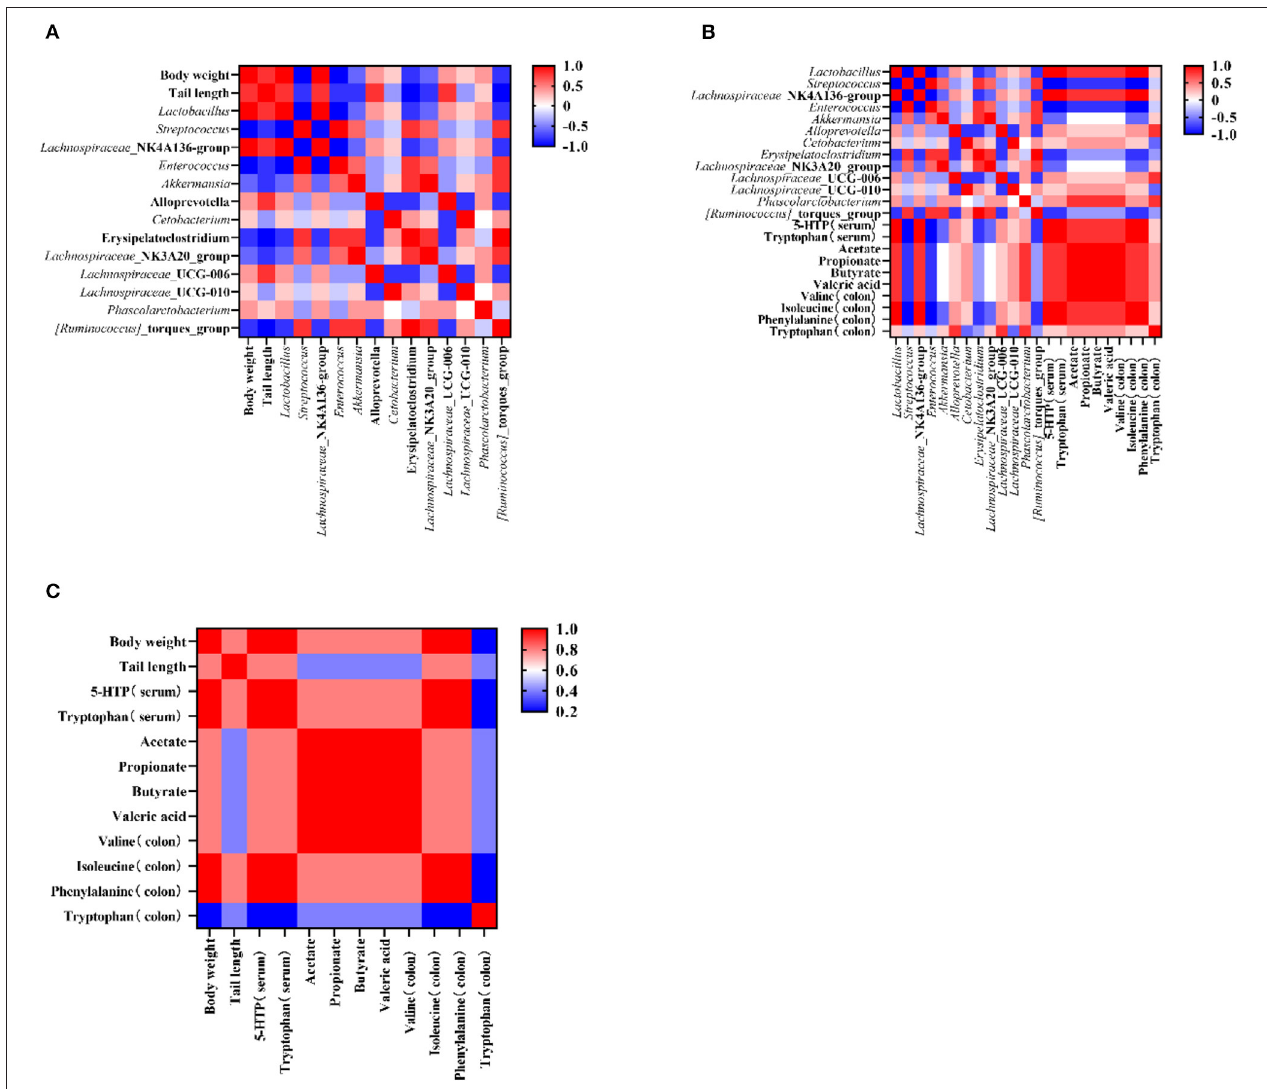
FIGURE 5 | The corelation among the targeted bacteria, apparent indicators, and metabolites (in the serum and the colon). (A) The corelation between targeted bacteria and apparent indicators. (B) The correlation between targeted bacteria and metabolites (in the colon and the serum). (C) The correlation between apparent indicators and metabolites (in the colon and the serum). Data are presented as mean ± SEM. Different letters indicate statistical differences among the groups ( p < 0.05). CTG, control group; LPG, low protein group; CG, casein group; SPG, soy protein